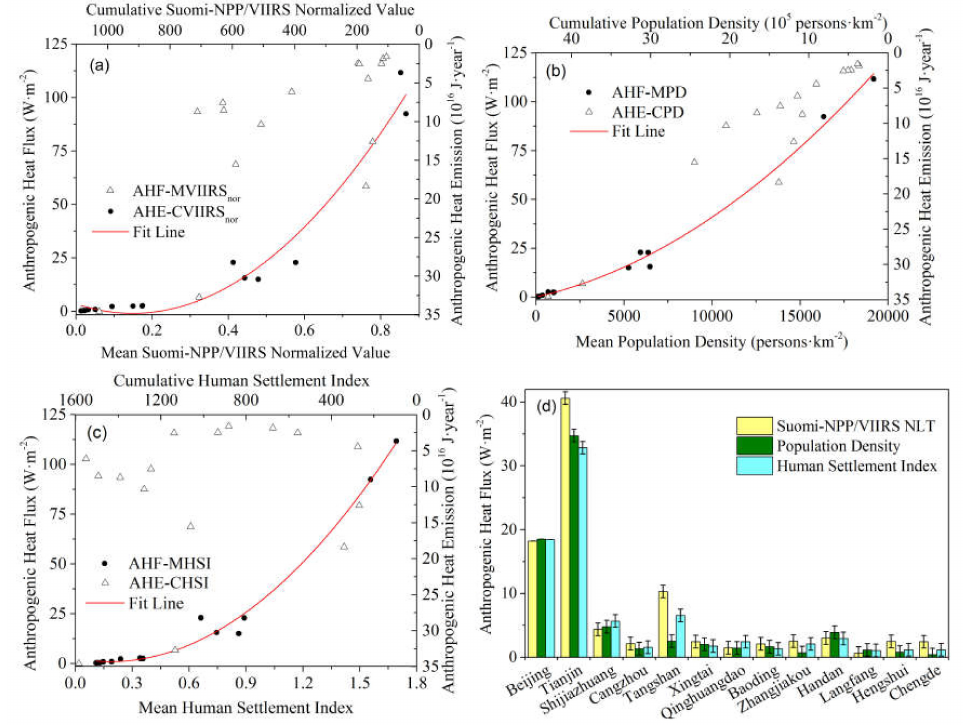
Figure 7. The statistical regression model between annual mean AHF and the average and cumulative values of the three kinds of proxy data respectively, and the accuracy comparison of each model. (( a ) The correlation between anthropogenic heat flux (AHF) and anthropogenic heat emission (AHE) with Suomi-NPP VIIRS nighttime light data normalized value (VIIRS nor ); ( b ) The correlation between AHF and AHE with population density (PD); ( c ) The correlation between AHF and AHE with human settlement index (HSI); ( d ) Estimation and residual between official statistics and estimation at the prefecture-level in the Beijing–Tianjin–Hebei region). Note: The meanings of AHF-MVIIRS nor , AHF-MPD and AHF-MHSI are shown in Table 4. AHE-CVIIRS nor represents AHE and cumulative Suomi-NPP VIIRS nighttime light data normalized value (CVIIRS nor ) at the county level in Beijing municipality; AHE-CPD represents AHE and cumulative population density (CPD) at the county level in Beijing municipality; AHE-CHSI represents AHE and the cumulative human settlement index (CHSI) at the county level in Beijing